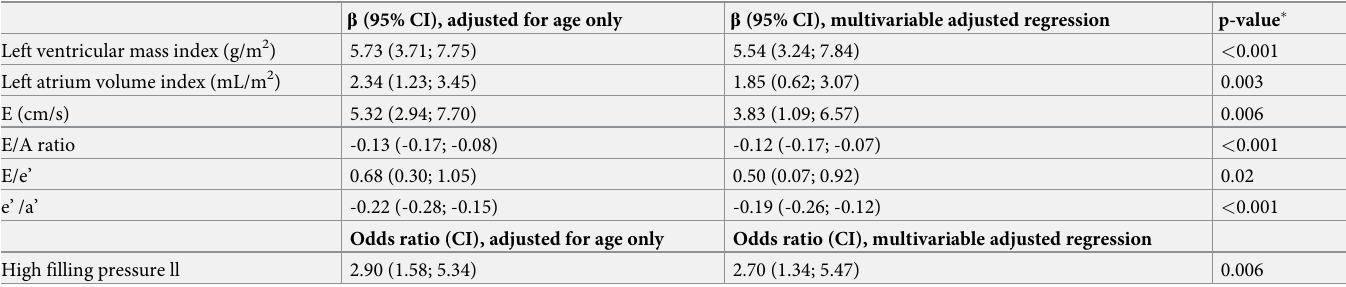
� p-value from separate multivariable logistic or linear regression with each echocardiographic parameters as outcome and a variable indicating population—women with angina/asymptomatic reference population—as an independent variable; adjusted for age, cardiovascular (CV) risk factors, heart rate, systolic and diastolic blood pressure, and CV medication from Table 1 (Echocardiographic parameter = β � ”women with angina/controls”+ β 1 � age+ β 2 � ”CV risk factors”+ β 3 � ”hemodynamic parameters”+ β 4 � ”CV medication”). β is the regression coefficient.